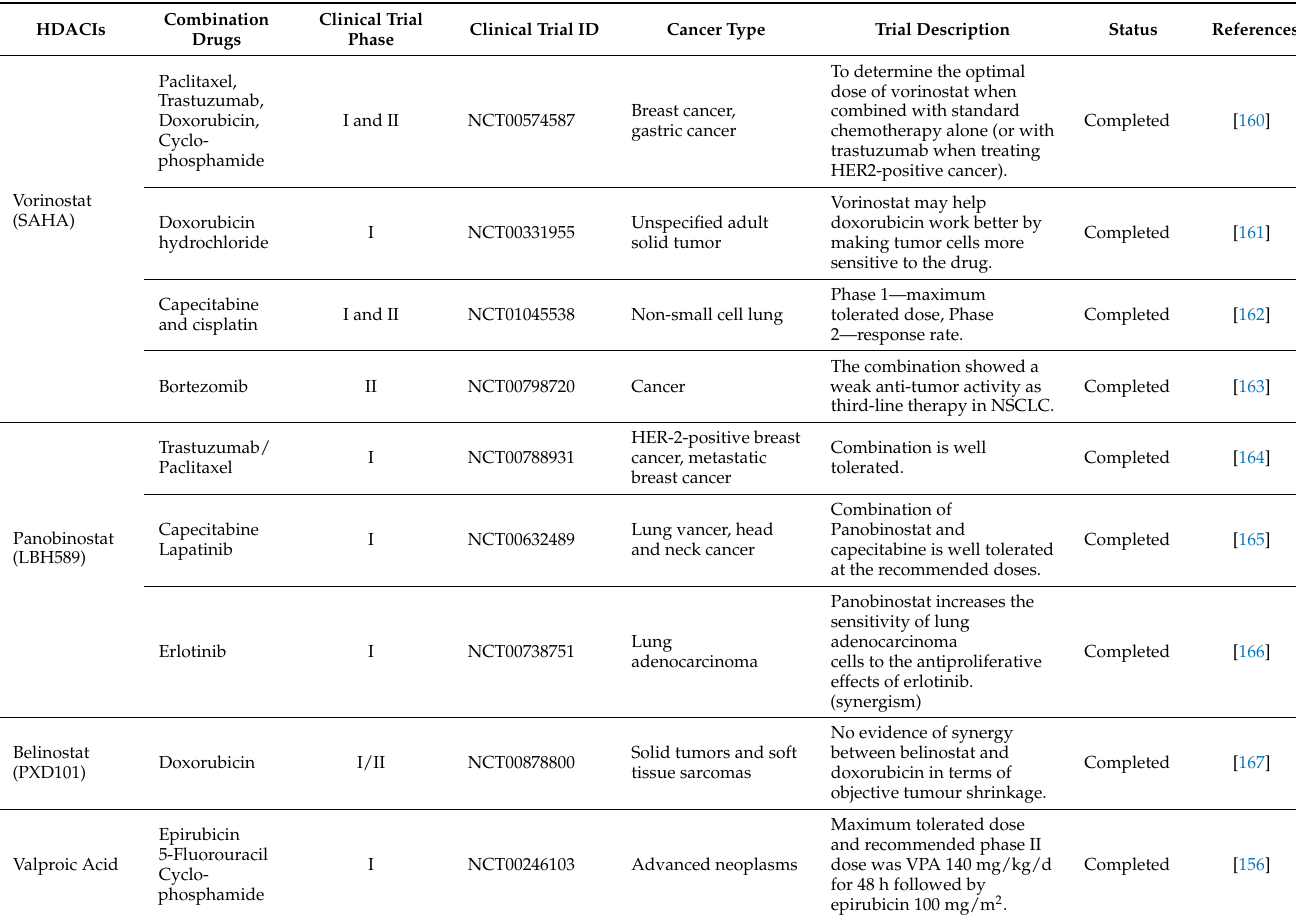
Table 3. Clinical trials of HDAC inhibitors in combination with other anticancer